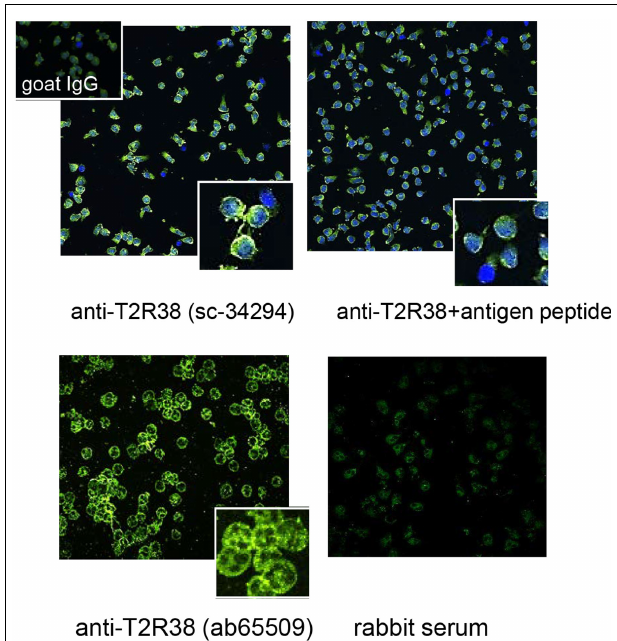
FIGURE 2 | Distribution of T2R38 on neutrophils: by laser scan microscopy, T2R38 was detected in neutrophils . The upper panel shows an image with anti-T2R38 sc-34294 (green) and nuclei are stained in blue. Binding of the antibody was partly inhibited by the antigen peptide. The antibody ab65509 (lower panel) also detected T2R38 (green), in association with the membrane, and with a speckled pattern intracellular. The lower right panel shows the image obtained with rabbit serum instead of the antibody (images were taken with 40 (cid:2) objective; digital zooms of representative areas are shown in the insets).